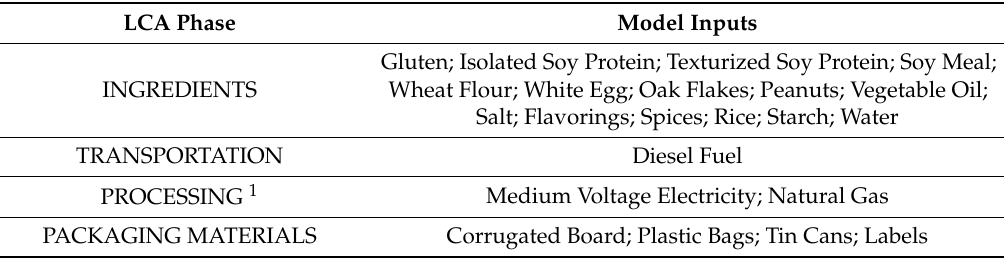
Table 1. Inputs for the four Life Cycle Assessment (LCA) production phases considered in this